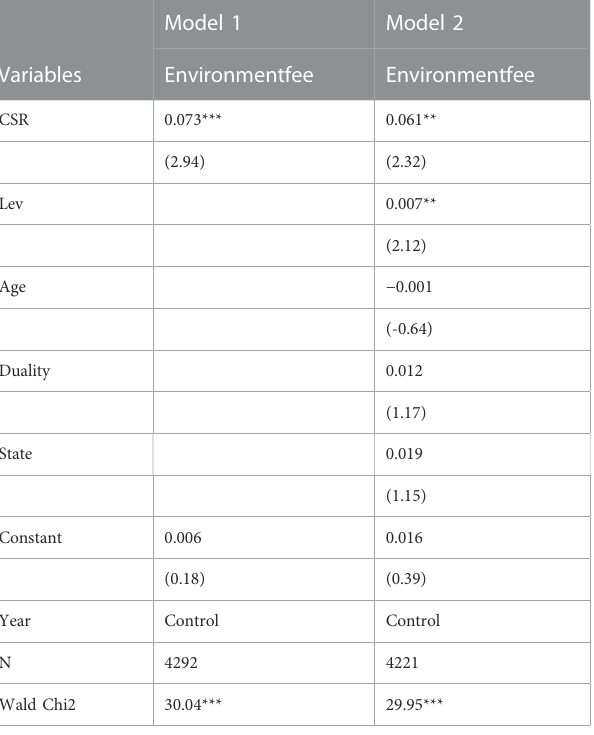
TABLE 5 Further analysis of fi rms in different